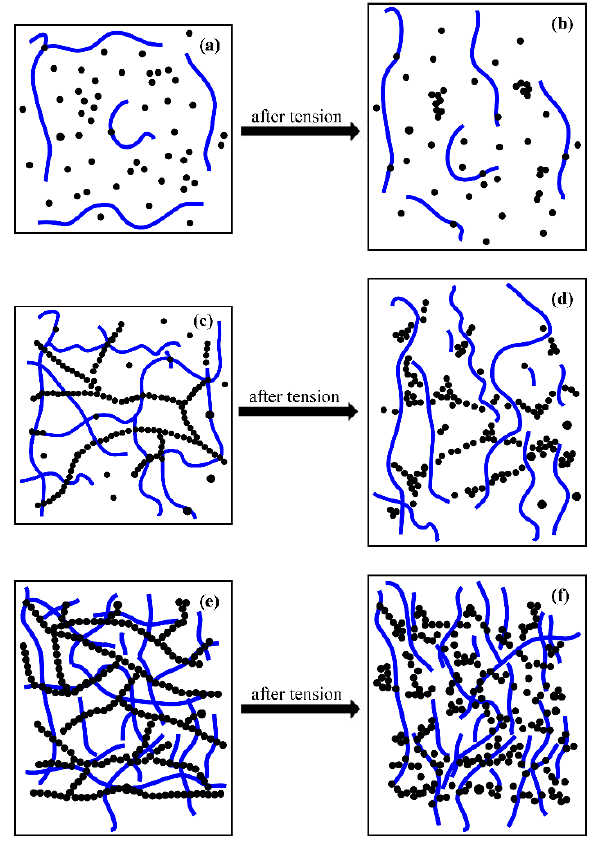
Figure 10. Schematics of filler networks: ( a , b ) 1.5 vol %; ( c , d ) 3 vol %; ( e , f ) 6 vol %; ( a , c , e ) initial condition; ( b , d , f ) after extension.